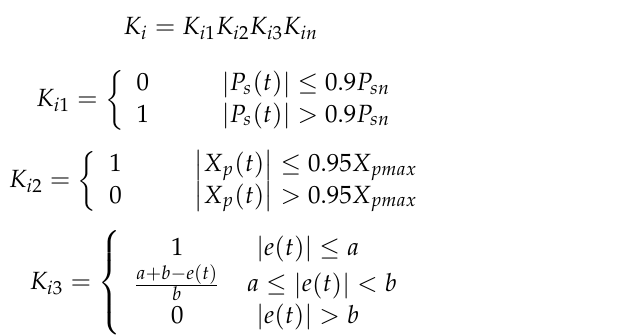
Figure 13. The dynamic pressure feedback (DPF) controlled system model illustration.